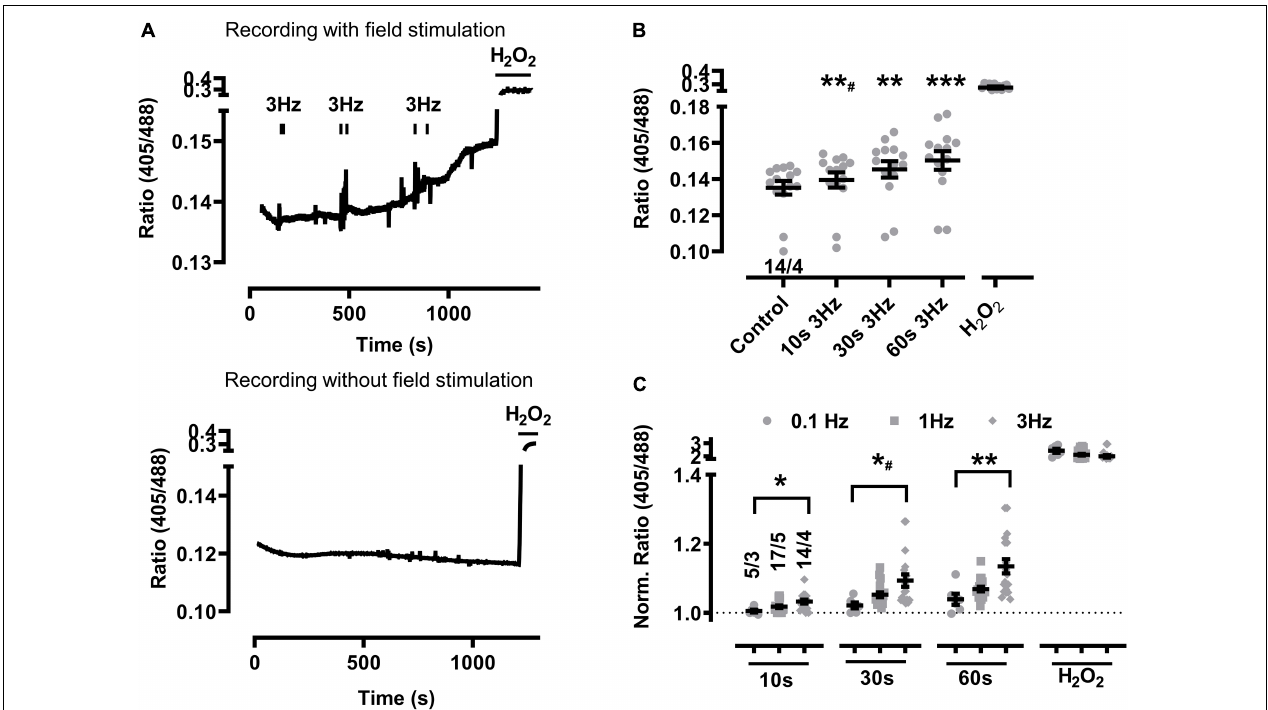
FIGURE 1 | Baseline mitochondrial oxidation at higher beating rates in sTG-cardiomyocytes. (A) Representative time course of the redox biosensor I405/I488 nm ratio following repeated EFS-evoked 3 Hz beating trains ( top ) compared to the absence of EFS-pacing in WT control cardiomyocytes ( bottom ). Black bars indicate the start and end of each beating interval lasting 10, 30, and 60 s as summarized by the graphical protocol in Supplementary Figure 1 . H 2 O 2 (200 µ M) was added at the end of each experiment to obtain the maximal level of mitochondrial oxidation. Of note, vertical “noise” may originate from aberrant cardiomyocyte contractions. (B) Dot plot showing the I405/I488 nm ratio of individual cells and mean values ± SEM. Measurements were obtained under baseline conditions and following EFS-pacing at 3 Hz for the indicated beating durations. Cell/heart numbers are indicated. Paired one-way ANOVA with Dunnett’s post-test. ** # P = 0.006; ** P = 0.002; *** P < 0.001. (C) Dot plot summarizing individual and mean ± SEM 405/488 nm normalized ratio values recorded at the indicated beating rates and train durations. Ratio values were normalized to baseline at the start of each experiment. Cell/heart numbers are indicated. Unpaired one-way ANOVA with Tukey’s post-test. * P = 0.01; * # P = 0.02; ** P =